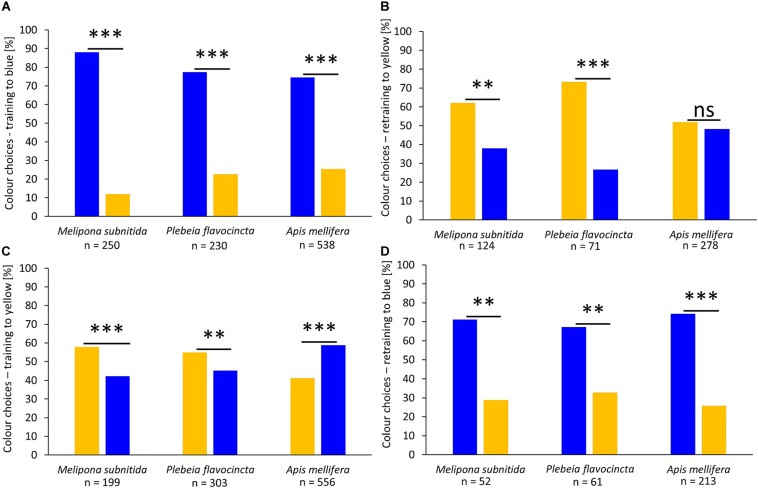
Color choices after training sessions. The three tested bee species were trained to forage on either a blue feeder (A) or a yellow feeder (C). Furthermore, the workers were retrained to the opposite color (B,D). A generalized linear mixed model was used for statistical analysis (∗∗p < 0.01; ∗∗∗p < 0.001; ns = not significant p
> 0.05).